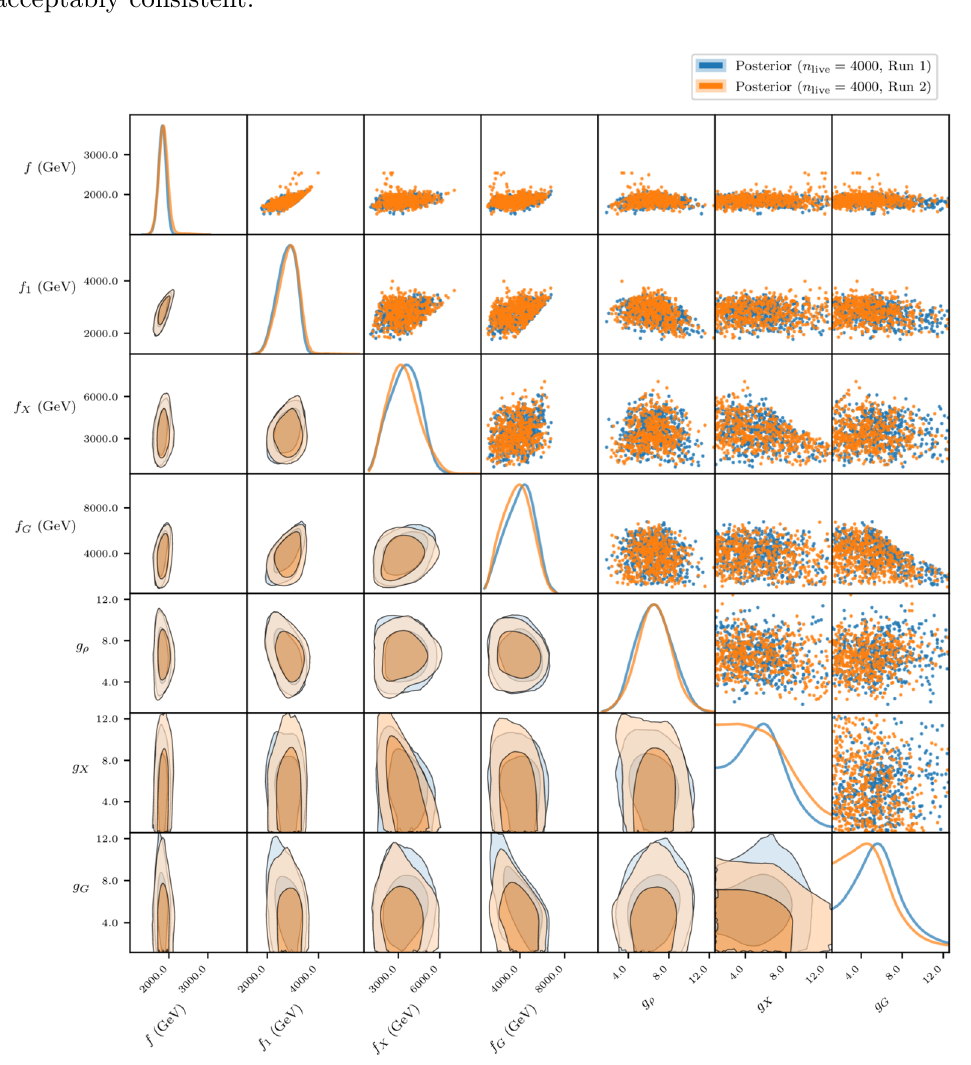
Figure 21. 1D and 2D marginalised posteriors for the gauge sector parameters in the M4DCHM 14 − 14 − 10 found in two different runs with 4000 live